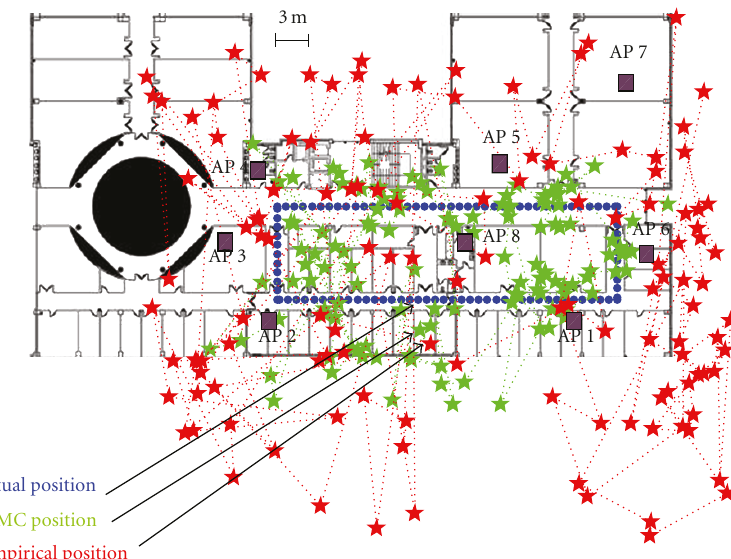
Figure 7: Multilateration obtained in the second floor of the ETSIT at the University of Valladolid. Blue dots represent actual positions, red ones are positions obtained by an empirical method, while green dots are positions after applying the localization algorithm proposed in this